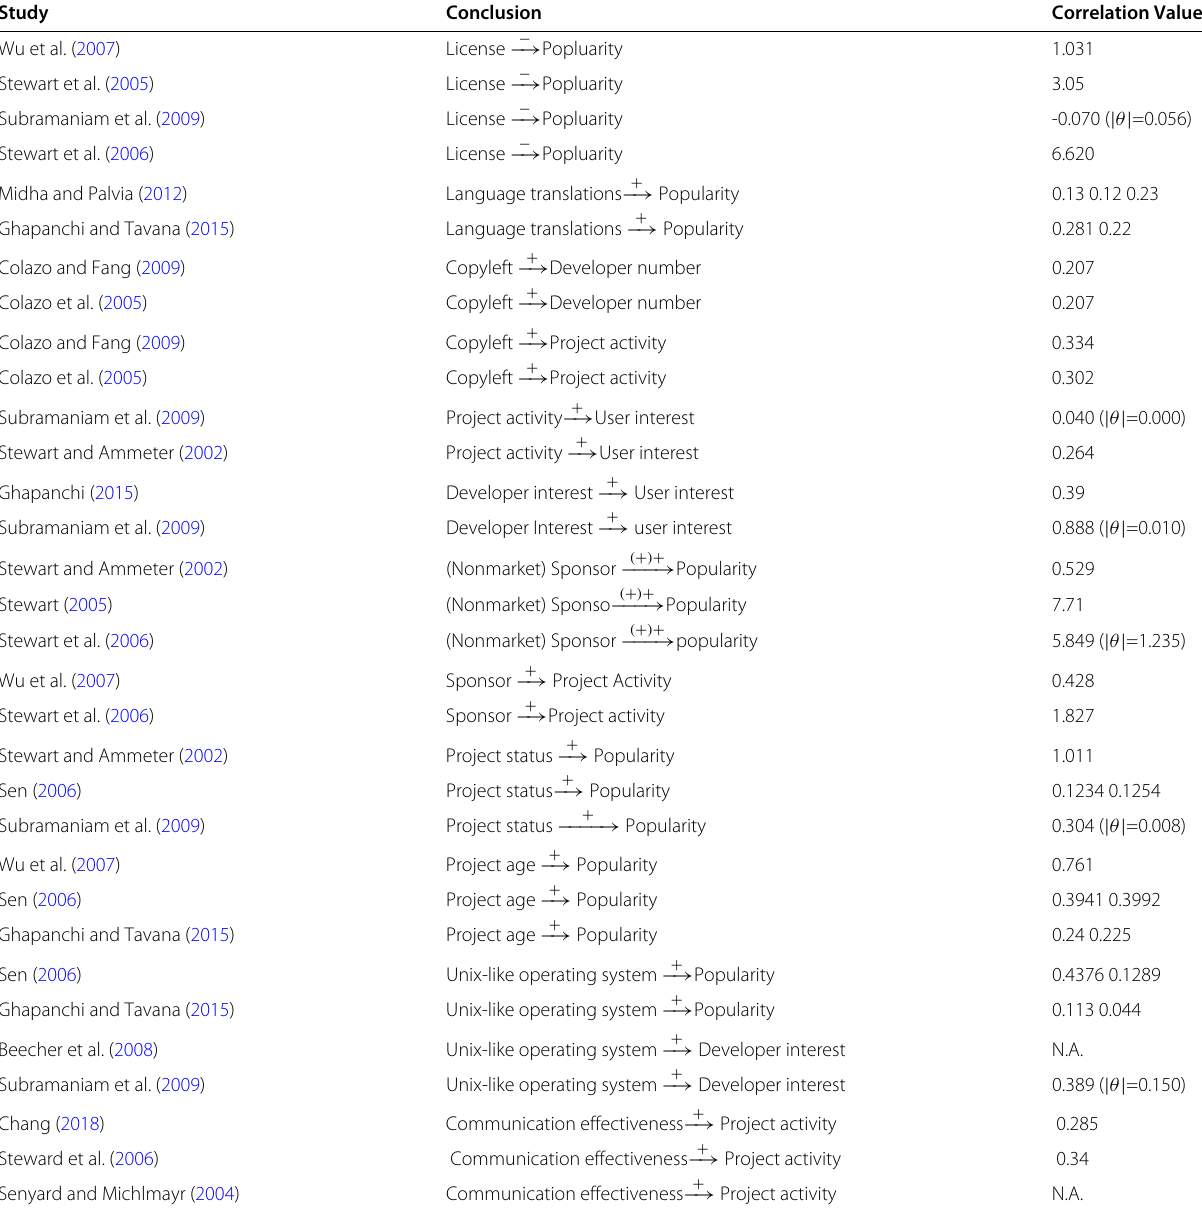
Table 8 The indicators have been analyzed and come to a consistent conclusion. “ A − −→ and “ A B ” indicates A has negative influence on B . θ is the threshold for correlation. Generally, a value larger than | θ | indicates